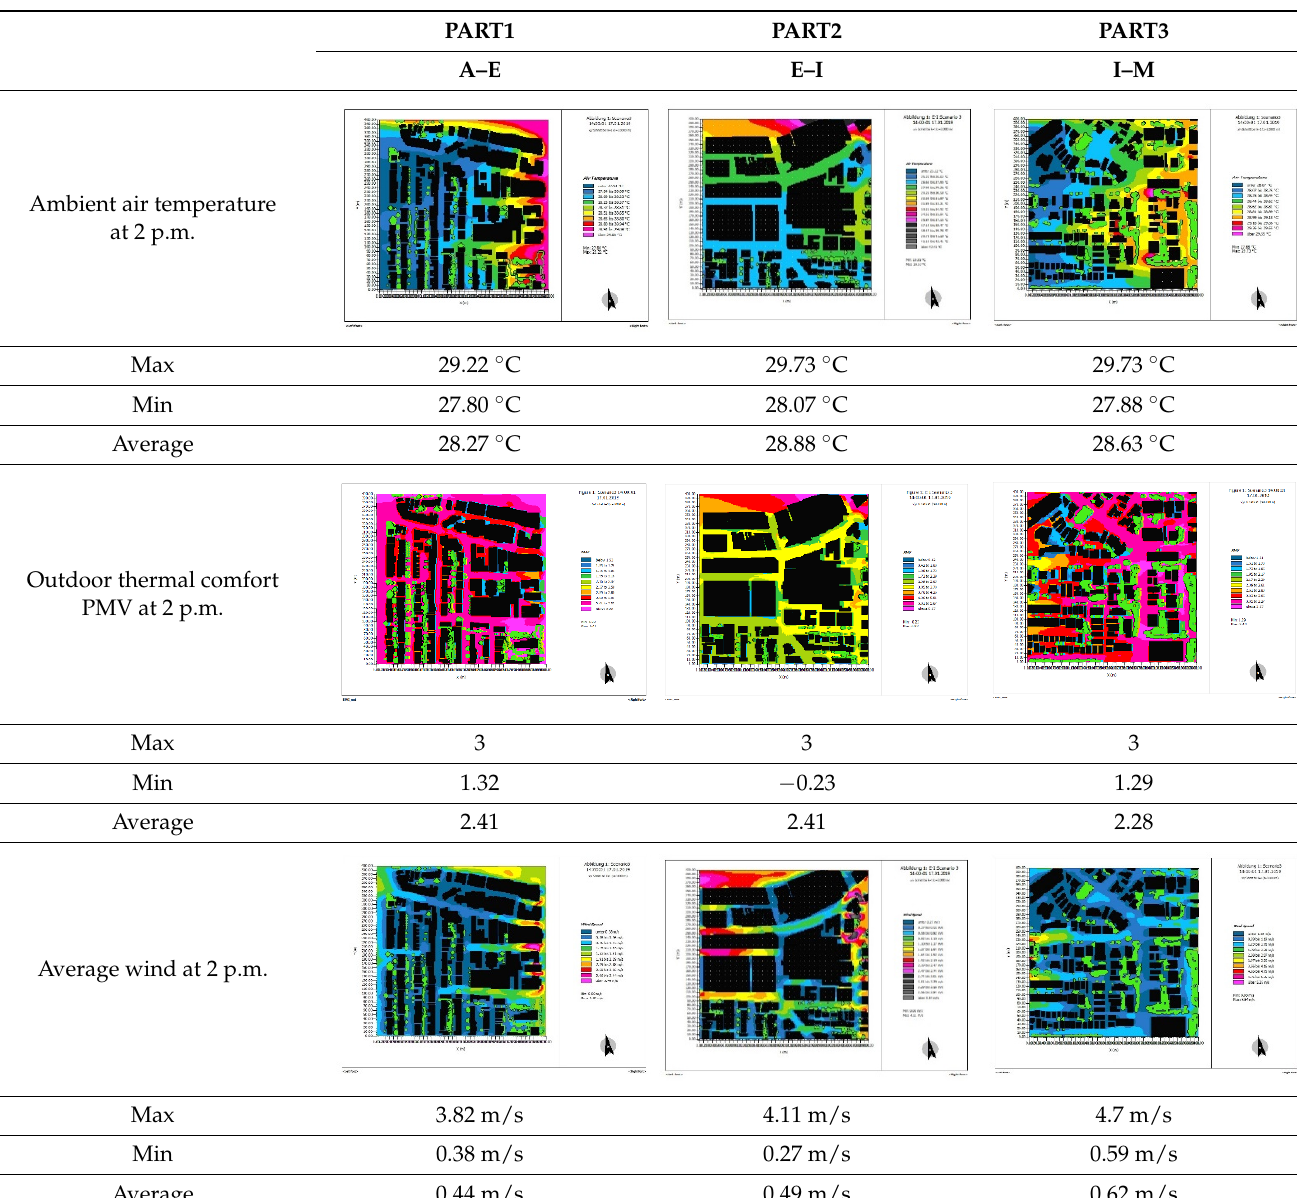
Table 10. Scenario three ambient air temperature, outdoor thermal comfort, and wind speed distribu- tion maps in all parts at 2 p.m.